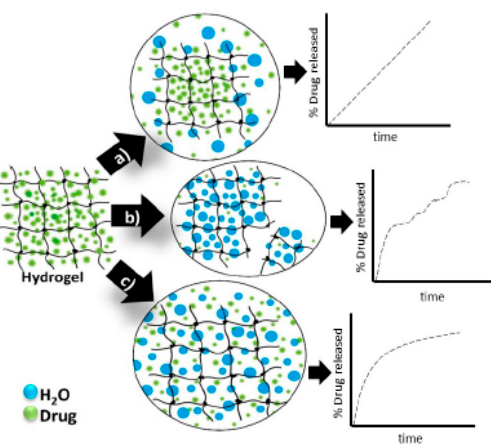
Figure 8. Hydrogels drug release mechanisms and their respective kinetic profiles: ( a ) drug diffusion, ( b ) degradation of the polymeric matrix and ( c ) swelling. Reprinted with permission from Ref. [203].